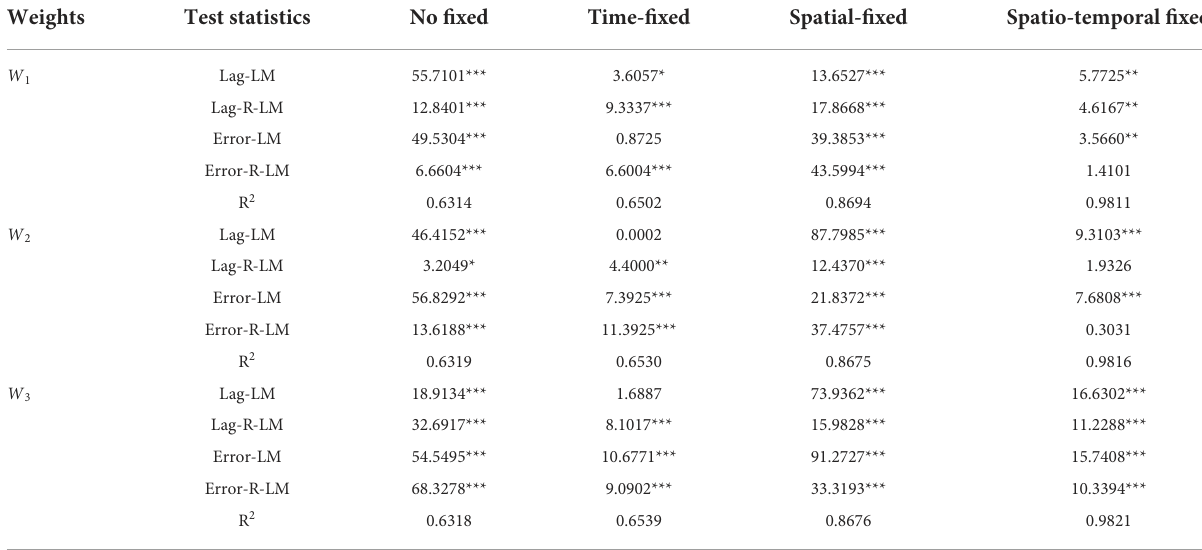
TABLE 6 Lagrangian multiplier (LM) test